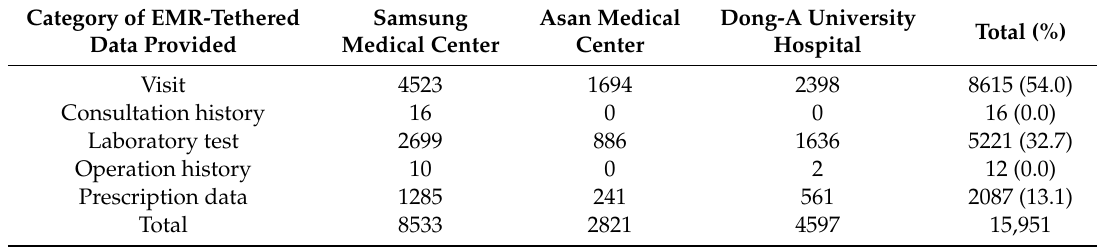
Table 3. Frequency of system access and utilization. Numbers indicate counts of EMR-tethered data provided during the study